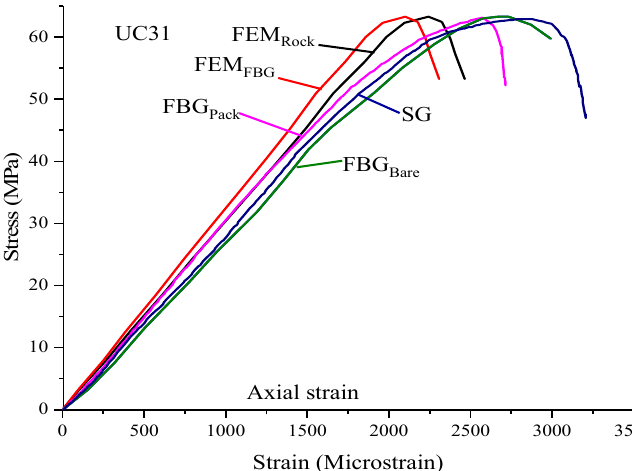
Figure 9. Comparison of experimental and numerical results of sample UCS31. Table 7. Comparison of stiffness parameters of FEM and experimental results.